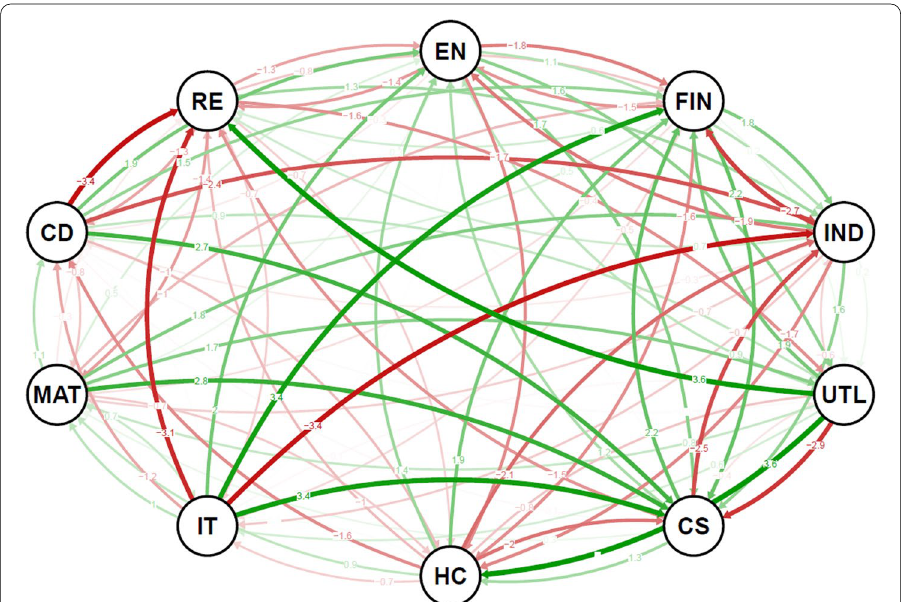
Fig. 9 Difference in spillover between lower ( τ 0.05) and upper ( τ 0.95) tails during COVID19 sub-sample. = = Note: This graph of the US sector network shows the difference in connectedness in the system for the lower and upper quantile levels during the COVID-19 sub-sample period. The connectedness is measured through the spillover approach proposed by Diebold-Yilmaz (2012). The thickness of an edge is proportional to its weight while colour implies increase (green) and decrease (red) in spillover during COVID-19